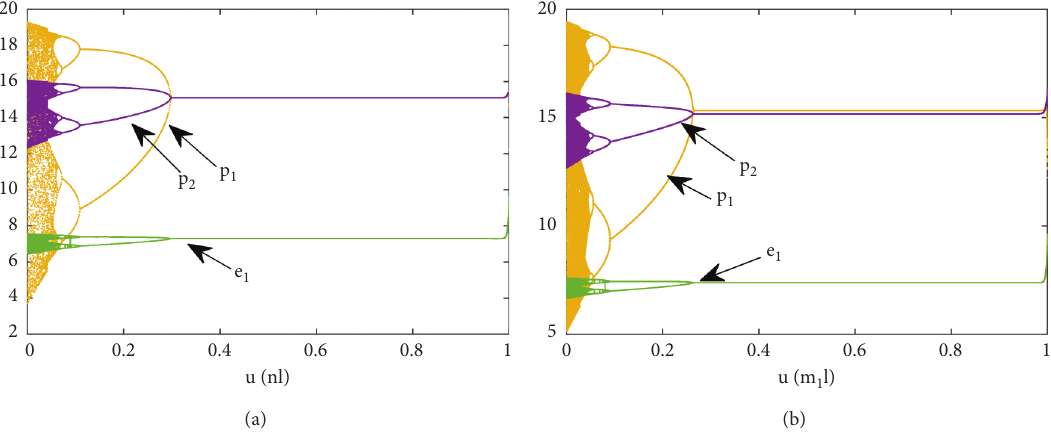
Figure 14: Bifurcation diagram with u increasing (a,